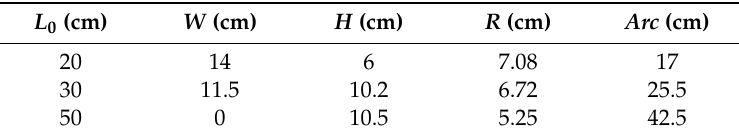
Table 3. The dimension of the Arc .